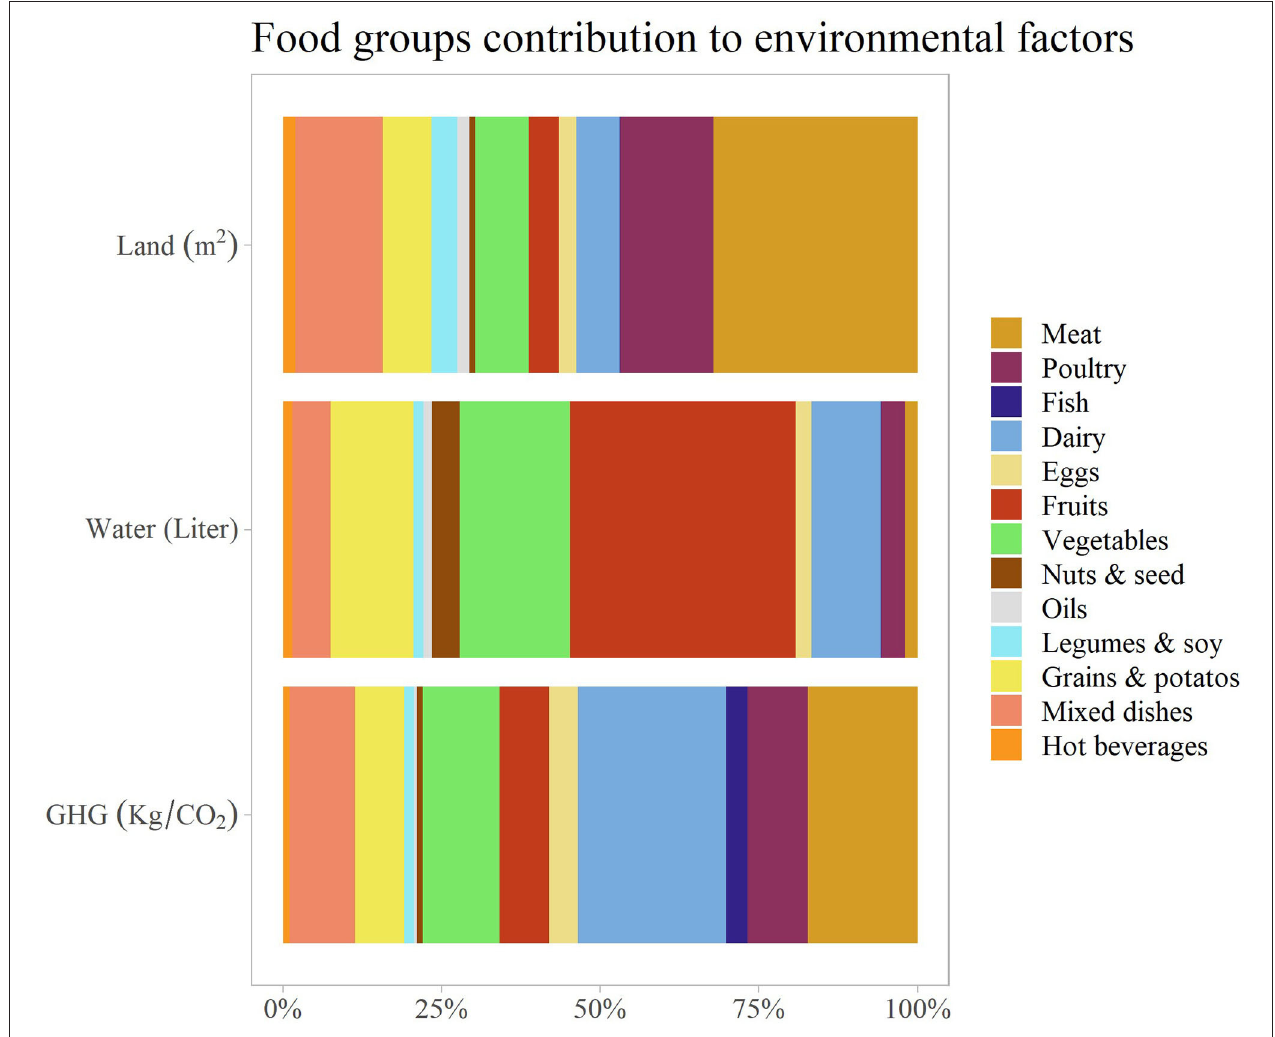
FIGURE 1 | Food groups’ relative contributions to land, water, and GHGs footprints.